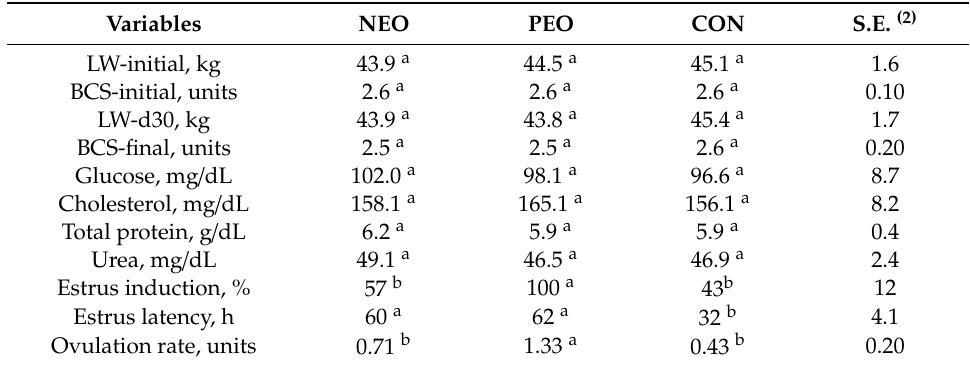
Table 2. Least square means regarding live weight (kg) body condition score (units), serum blood metabolites, and ovarian traits in adult mix-breed (Alpine-Saanen-Nubian × Criollo; n = 45) female goats supplemented with Opuntia megacantha Salm-Dyck cladodes either natural (NEO) or protein-enriched (PEO) or non-supplemented control (CON). Adult goats were exposed to testosterone treated bucks and faced an increased natural photoperiod (Apr–June; anestrous season) under semiarid-subtropical rangeland conditions in Northern Mexico (25 ◦ N) (1)